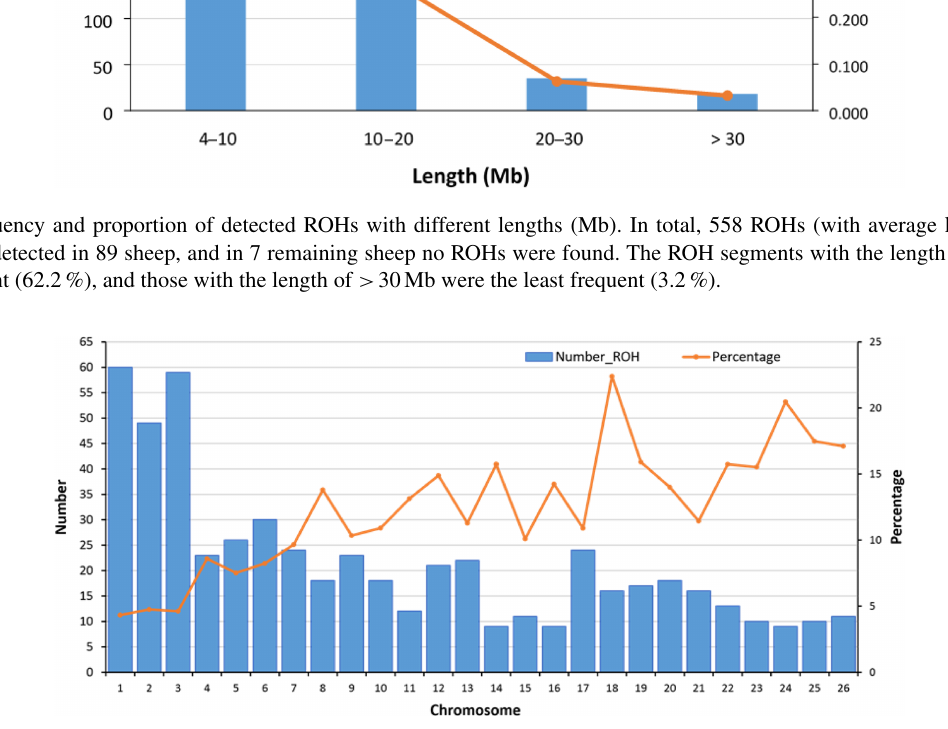
Figure 4. Number of detected ROHs and percent of coverage per autosome. In total, 558 ROHs were detected. For each autosome, the average length of a ROH (for the sheep with at least one ROH) was divided by the length of the chromosome to calculate the percentage of each autosome covered by ROHs. OAR1 with 60 ROHs (average length of 12 . 9 ± 8 . 8Mb) had the highest number of ROHs, and OAR14, OAR16, and OAR24 with 9 ROHs (average length of 10 . 3 ± 5 . 9Mb) had the lowest number of